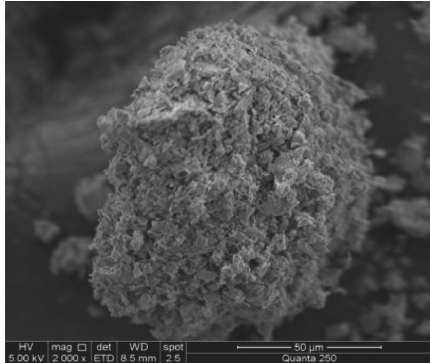
Figure 2: SEM image of the modified sepiolite.